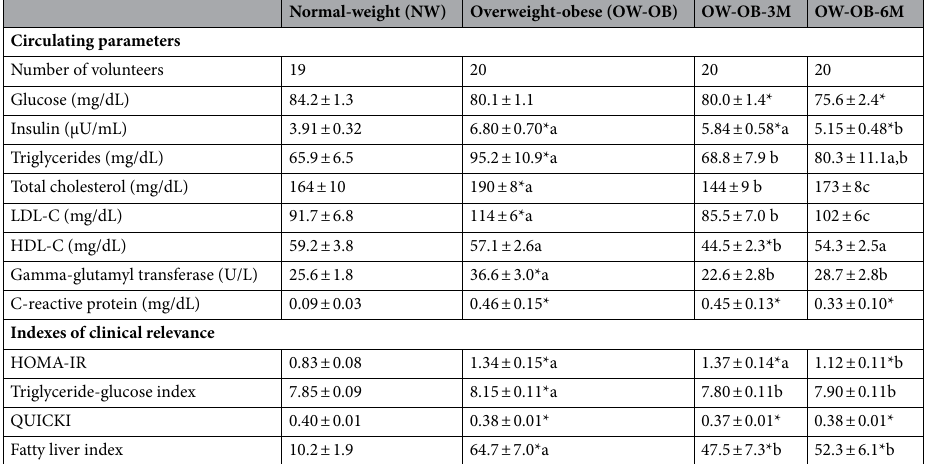
Table 4. Circulating parameters and indexes of clinical relevance in overweight-obese participants that completed the 6-month intervention. Data are mean ± S.E.M (n = 20 in the NW and n = 20 in the different OW-OB groups). Statistics: within the OW-OB groups, values not sharing a common letter (a, b) are significantly different (repeated measures ANOVA, p < 0.05); no letter indicates no significant differences; * indicates values significantly different vs NW group (Student’s t test, p < 0.05). Data of circulating parameters in the NW group correspond to 19 subjects because of missing data of one volunteer.